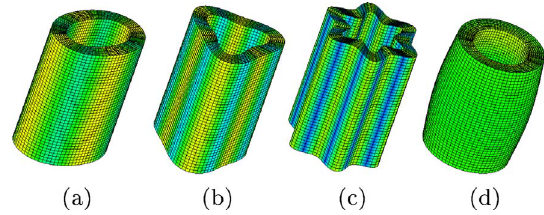
Figure 11. Mode shapes of the multi-layer reactor. (a) mode (2,0) at 10 Hz; (b) mode (3,0) at 29 Hz; (c) mode (6,0) at 134 Hz; (d) mode (0,0) at 737 Hz.